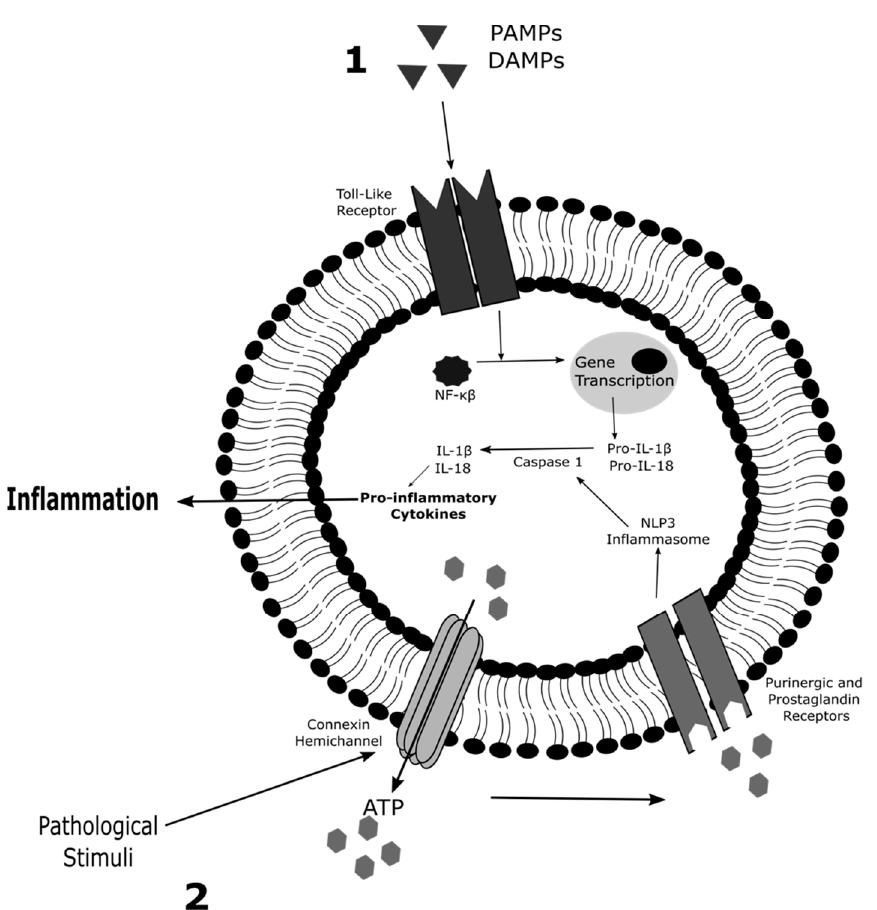
Figure 2. Role of connexin hemichannels in canonical inflammation activation. Canonical inflam ‐ masome activation requires two signals. (1) Damage ‐ associated molecular patterns (DAMPs) and pathogen ‐ associated molecular patterns (PAMPs) interact with Toll ‐ like receptors of immune cells to induce inflammation. The binding of DAMPs and PAMPs promotes the transfer of nuclear factor (NF) ‐κβ to the nucleus to activate gene expression. Thus, the transcription of the genes encoding premature forms of interleukin (IL) ‐ 1 β and IL ‐ 18 is triggered. (2) Pathogenic stimuli drive the open ‐ ing of connexin hemichannels, promoting the extracellular release of adenosine triphosphate (ATP). Extracellular ATP molecules stimulate P2X7 receptors, leading to nucleotide ‐ binding oligomeriza ‐ tion domain leucine rich repeat and pyrin domain ‐ containing protein 3 (NLP3) inflammasome acti ‐ vation. NLP3 inflammasome activation triggers the onset of caspase 1, which influences the inflam ‐ matory process by cleaving pro ‐ IL ‐ 1 β and pro ‐ IL ‐ 18 to their mature form and producing other pro ‐ inflammatory cytokines.